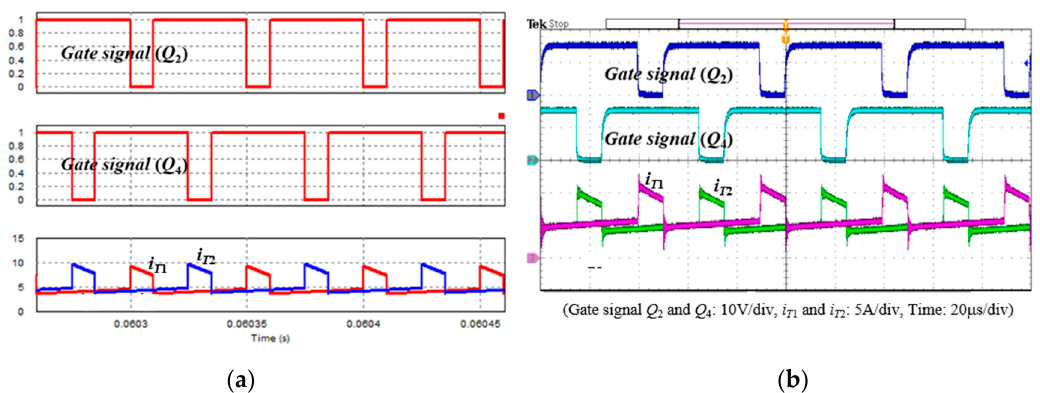
Figure 12. Waveforms of the switching gate signals and the primary-side currents of the coupled inductor in the UC recharging mode with D c = 0.8: ( a ) simulated and ( b ) experimental.